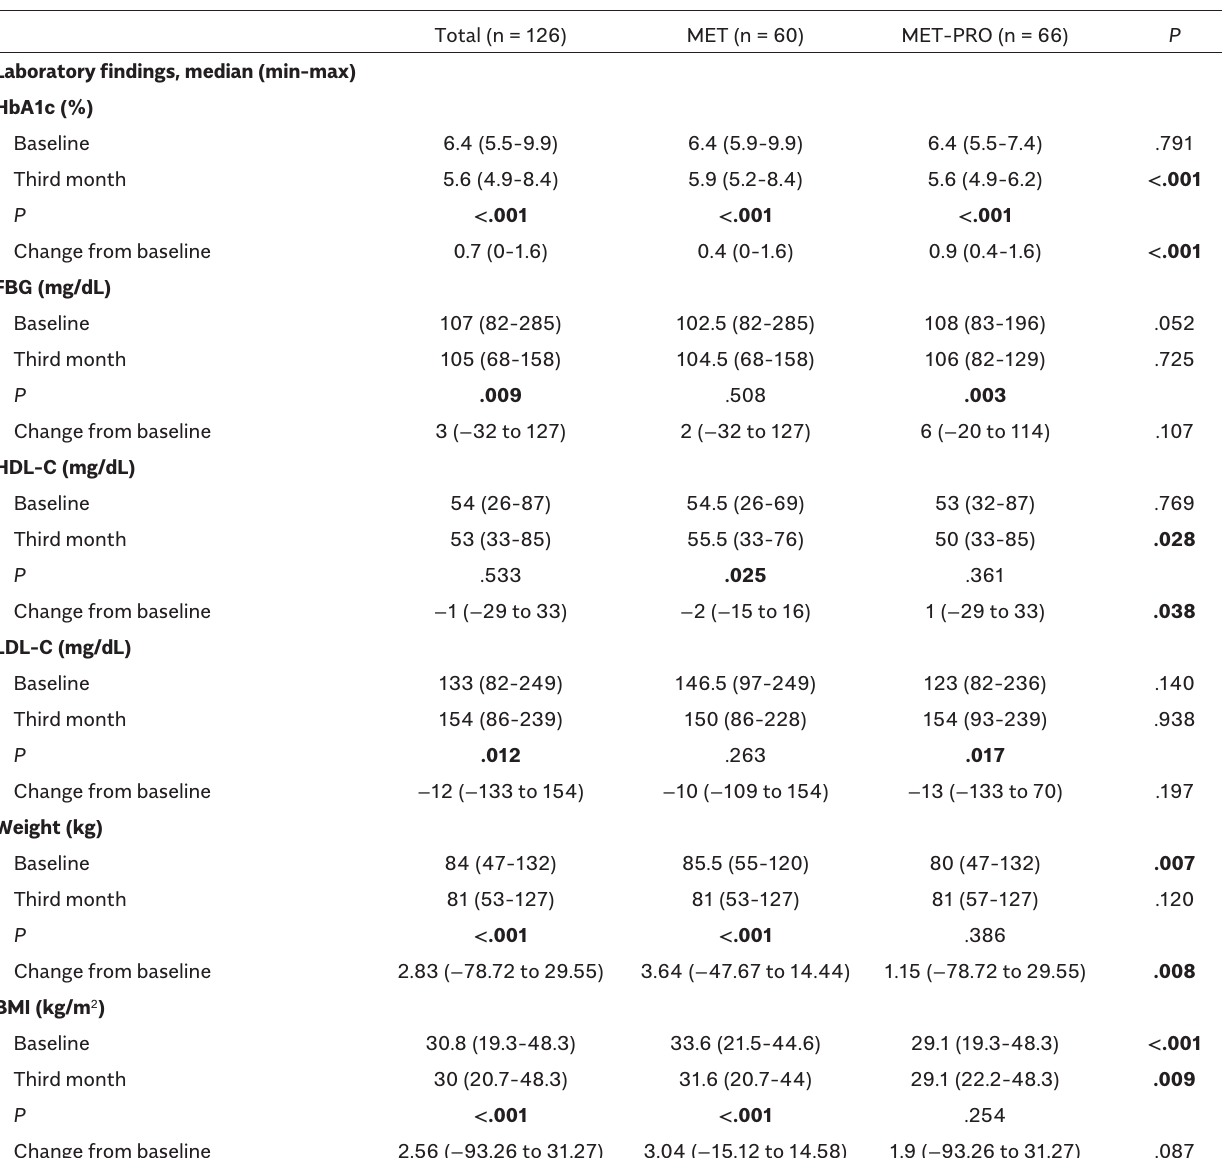
Table 2. Laboratory Findings in Patients Compliant with Treatment (n = 126) Total (n = 126) MET (n = 60) MET-PRO (n = 66) P Laboratory findings, median (min-max) HbA1c